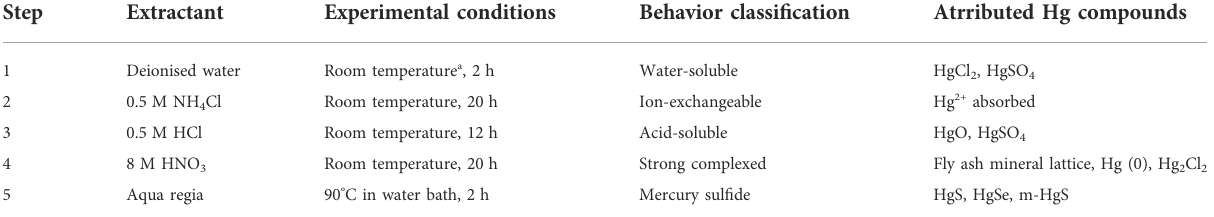
TABLE 2 Five-step sequential chemical extraction procedure and attributed Hg forms in each step (modi fi ed from Diao et al., 2018; O ’ Connor et al.,